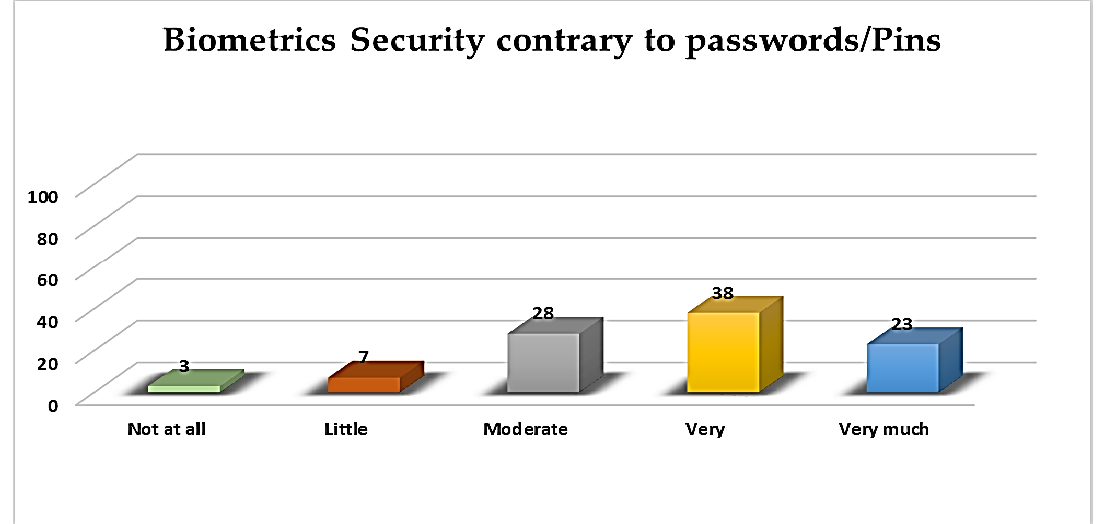
Figure 14. BS security contrary to passwords/PINS .